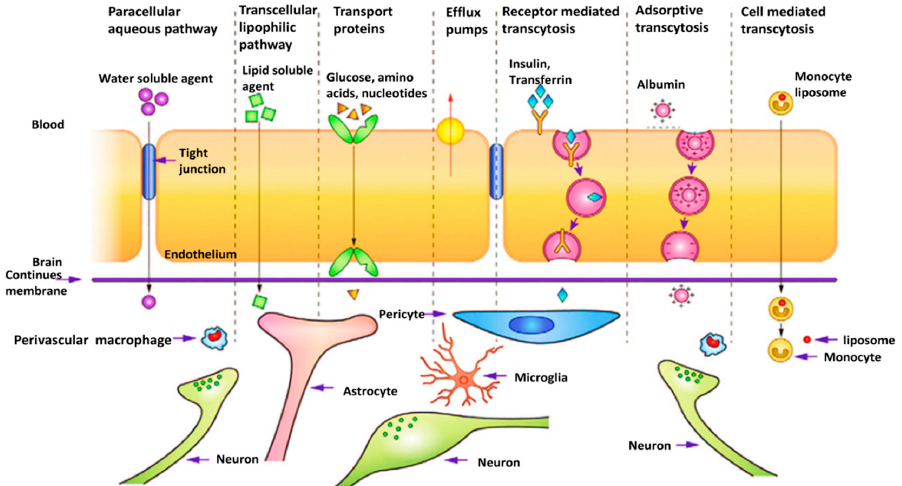
Figure 3. Different transportation mechanisms could be used for passing the BBB and delivering the drug to the glioblastoma cells. There are two main mechanisms for transporting molecules through the BBB: the paracellular pathway and the transcellular pathway which contains four different subparts: Receptor-mediated transcytosis, adsorptive-mediated, carrier/transporter-mediated transcytosis, and cell-mediated transcytosis. Reprinted with permission from [154].